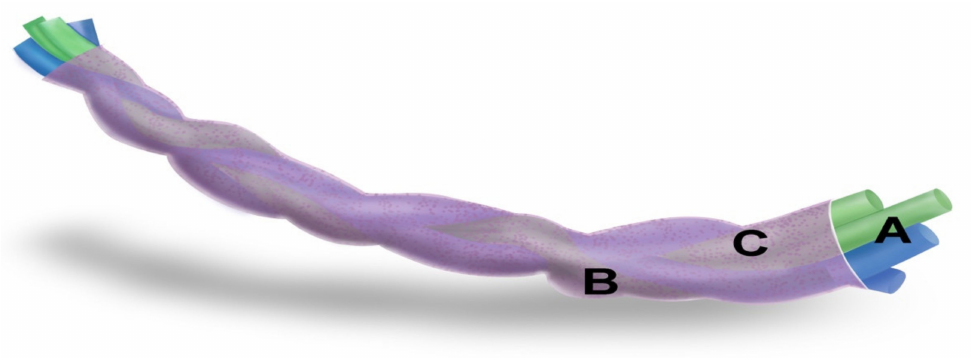
Figure 3. Illustration of BraidStent-SF-MMC. A —BraidStent; B —SF coating; C —MMC embedded in SF